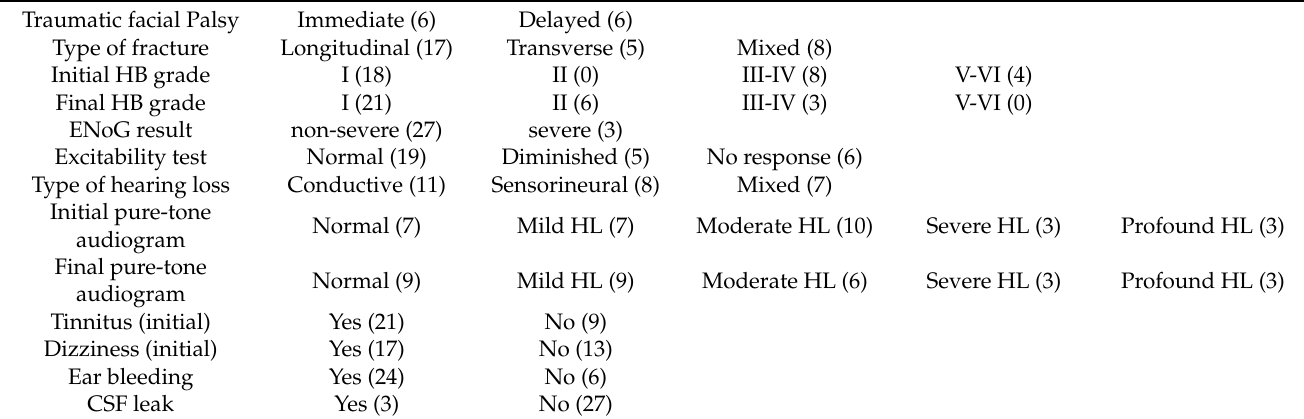
Table 1. Neurotological findings in patients ( n = 30) initially and at follow-up after temporal bone fracture. Into brackets: number of patients. HL: hearing loss, ENoG: electroneurography of facial n